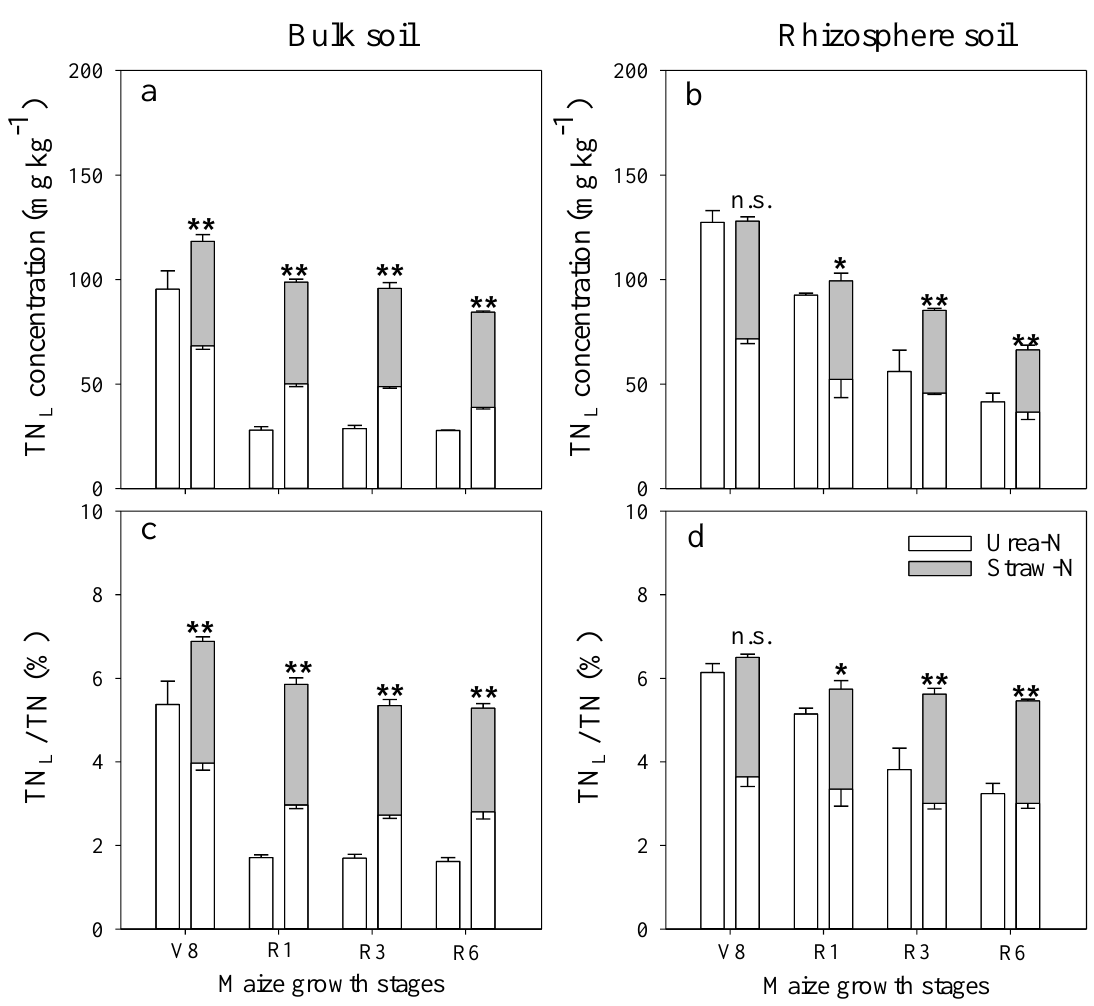
Figure 3. Concentration ( a , b ) and percentage ( c , d ) of labeled applied N (N L ) present as total N (TN) in bulk and rhizosphere soil in different fertilizer treatment during maize growth. White-only bars represent urea treatment (U). White plus gray bars represent urea combined with straw treatment (US). Maize growth stage: V8, R1, R3, and R6 respectively represent 8th leaf stage, silking stage, milk stage, and physiological maturity. Data shown are mean ± standard deviation of three replicates; * and ** denote significant differences at p < 0.05 and p < 0.01, respectively; n.s., not significant ( p > 0.05).